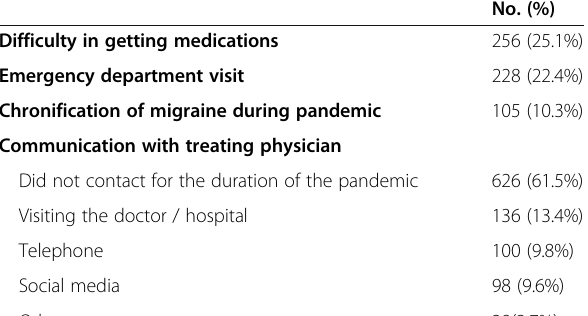
Table 1 Distribution of survey respondents according to